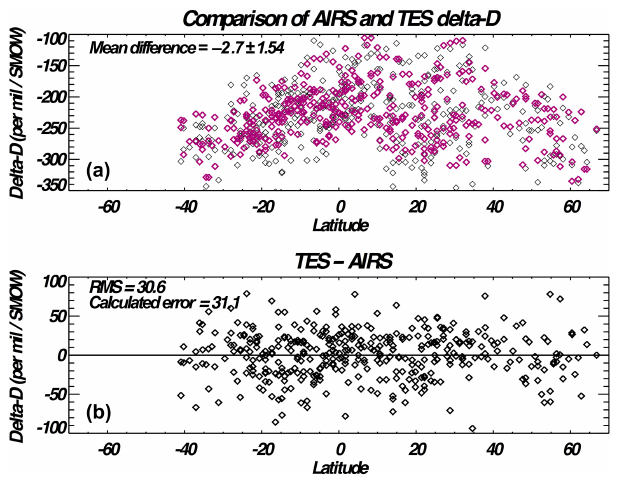
Figure 4. (a) Comparison of AIRS (red) and TES (black) delta-D for June 1 2006 ( ∼ 600 co-located observations). (b) The differ- ences (after bias subtraction) between TES and AIRS delta-D mea-